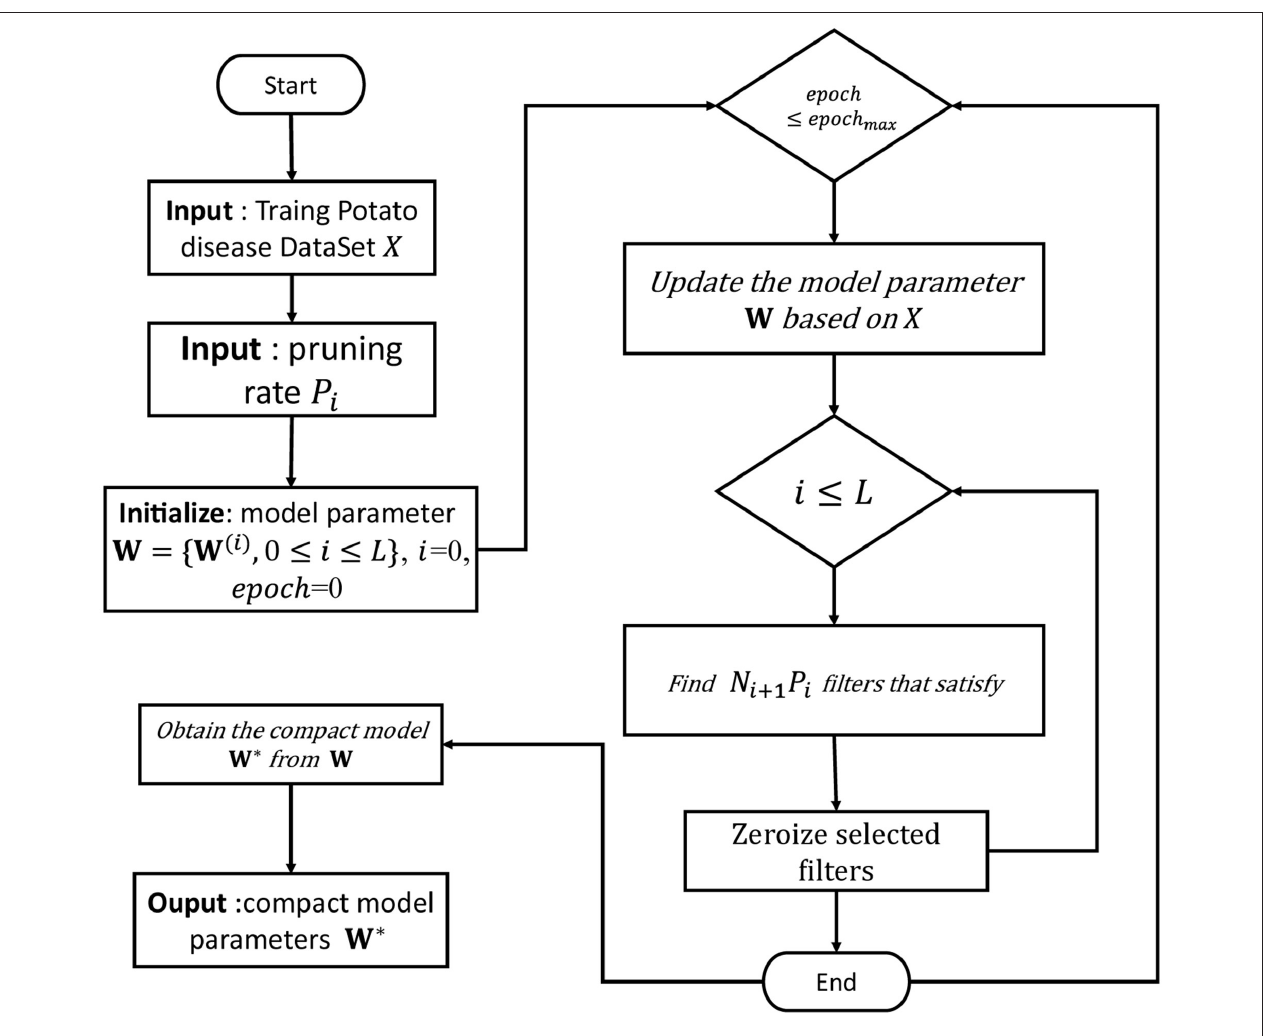
FIGURE 3 | FPGM pruning